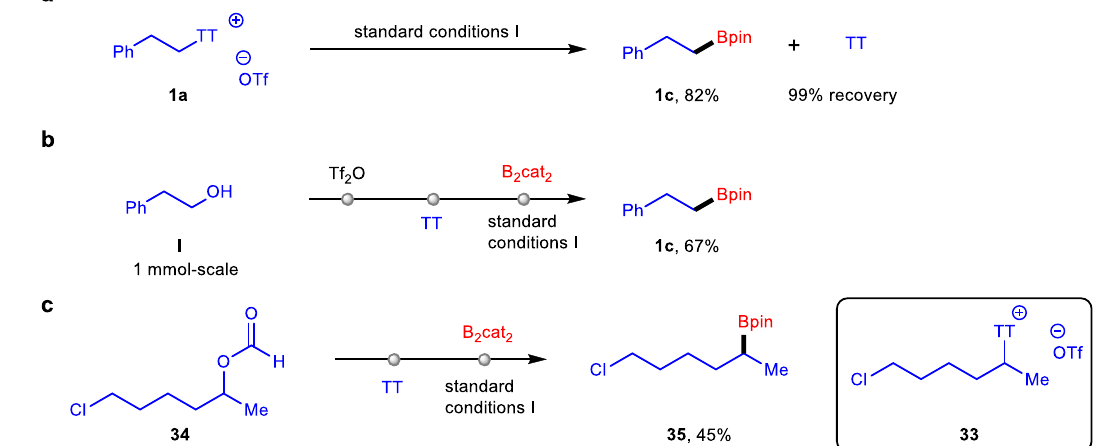
Fig. 5 Further investigations. a Recovery of TT reagent. b One-pot protocol from alcohol I to alkylboronate 1c . c One-pot protocol from formyloxy 34 to alkylboronate 35